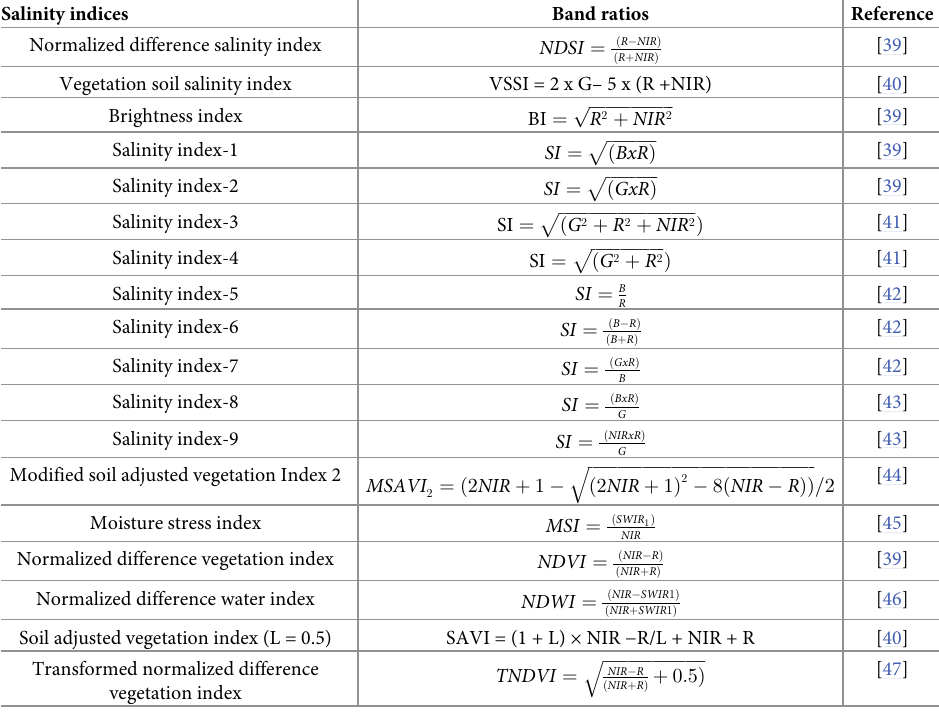
Table 2. Equations used to analyze soil salinity and vegetation indices.